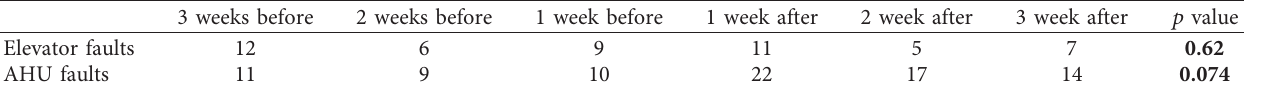
Table 4: Two examples of low-quality maintenance